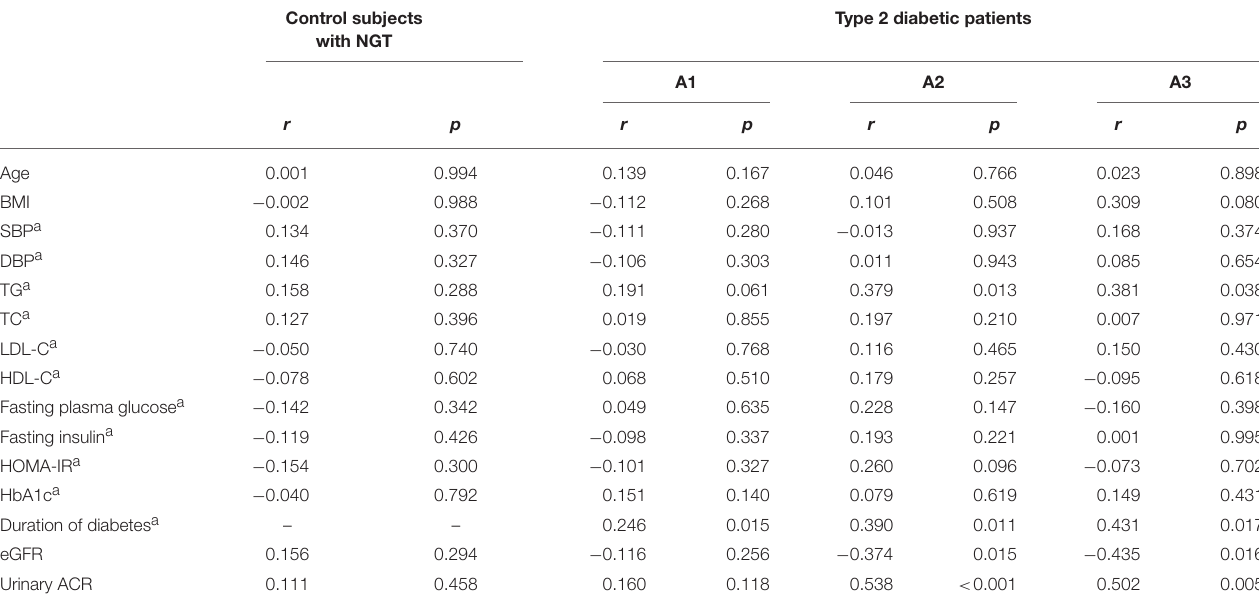
TABLE 2 | Correlations analysis of variables with circulating ANGPTL8 levels in control subjects with normal glucose tolerance (NGT), and T2DM patients with A1, A2, and A3.